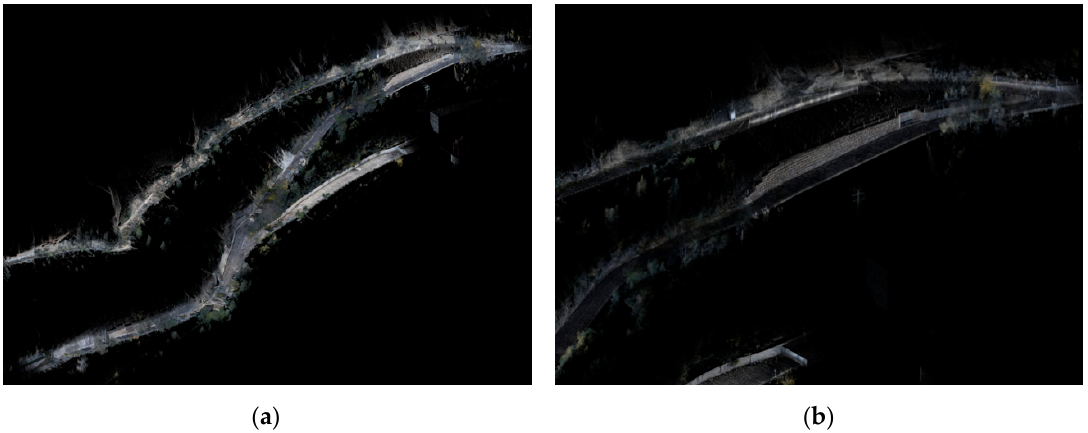
Figure 16. Colorized MMS (Mobile Mapping System) point cloud: ( a ) overview of the entire survey, ( b ) close-up view of a portion of the surveyed area.